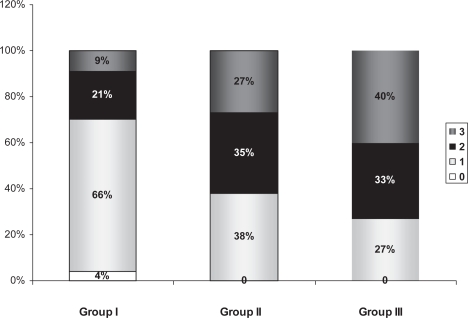
Comparison of vessel score in the different age groups.